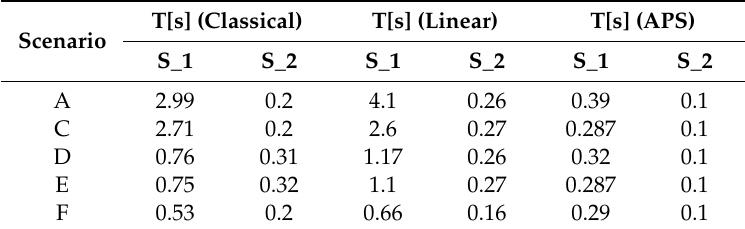
Table 6. Comparison of operating times (classical, linear programming, and smart-sensor APS coordination) for di ff erent fault types and